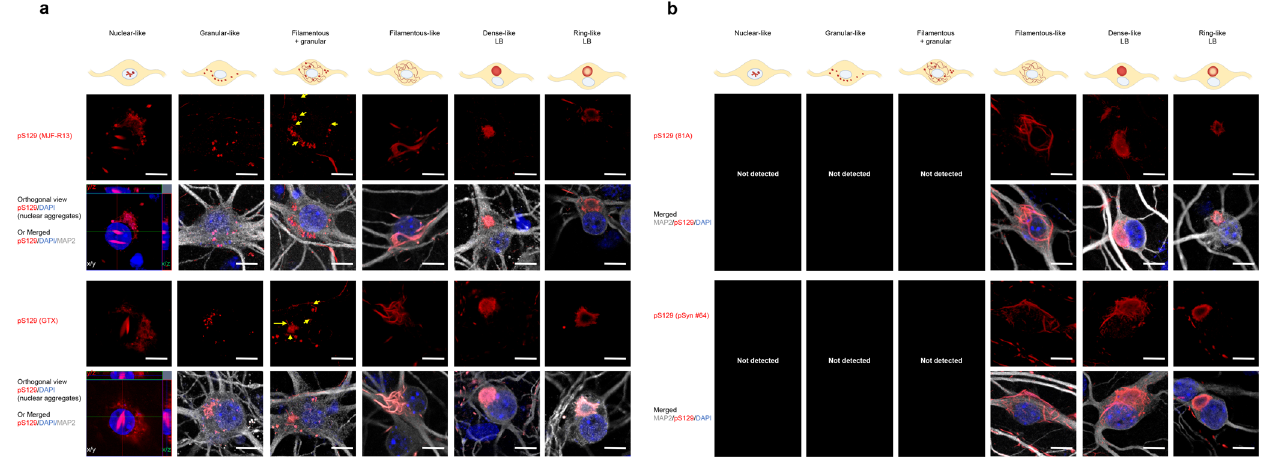
Fig. 5 All the pS129 antibodies do not detect the morphological diversity of the pS129-aSyn seeded-aggregates formed in human PFF- treated cortical neurons. a , b After 21 days of treatment with 70 nM of human E83Q aSyn PFFs, primary cortical neurons were fi xed, and ICC was performed. The seeded-aggregates were detected using the pS129 antibodies (MJF-R13, GTX, 81A, or pSyn#64). Neurons were counterstained with the MAP2 antibody and the nucleus with DAPI staining. Scale bar = 10 μ M. All four pS129 antibodies were able to distinguish the seeded-aggregates with the fi lamentous-like morphology and the LB-like inclusions with the dense core and the ring-like morphology. However, only the MJF-R13 and GTX antibodies were able to detect the nuclear, granular or granular and fi lamentous-like aggregates ( a ). The yellow arrows indicate the fi lamentous-like aggregates imbricated between the granular-like aggregates. The orthogonal view from different planes ( x / y , x / z , and y / z ) of the “ nuclear-like ” pS129-aSyn aggregates stained with MJF-R13 or GTX antibodies as well as the Imaris 3D animations (see Videos in SI fi les) con fi rmed their intranuclear localization. The schematic representation of the different types of seeded-aggregates was created using